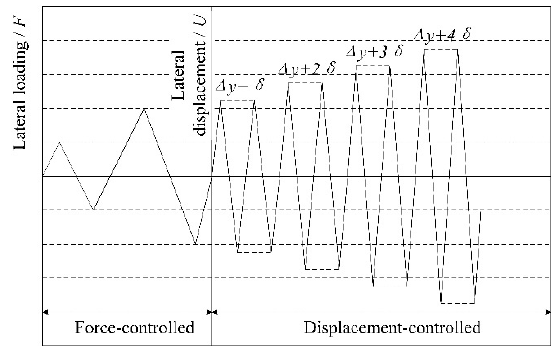
Figure 5. Low-reversed cyclic loading law.